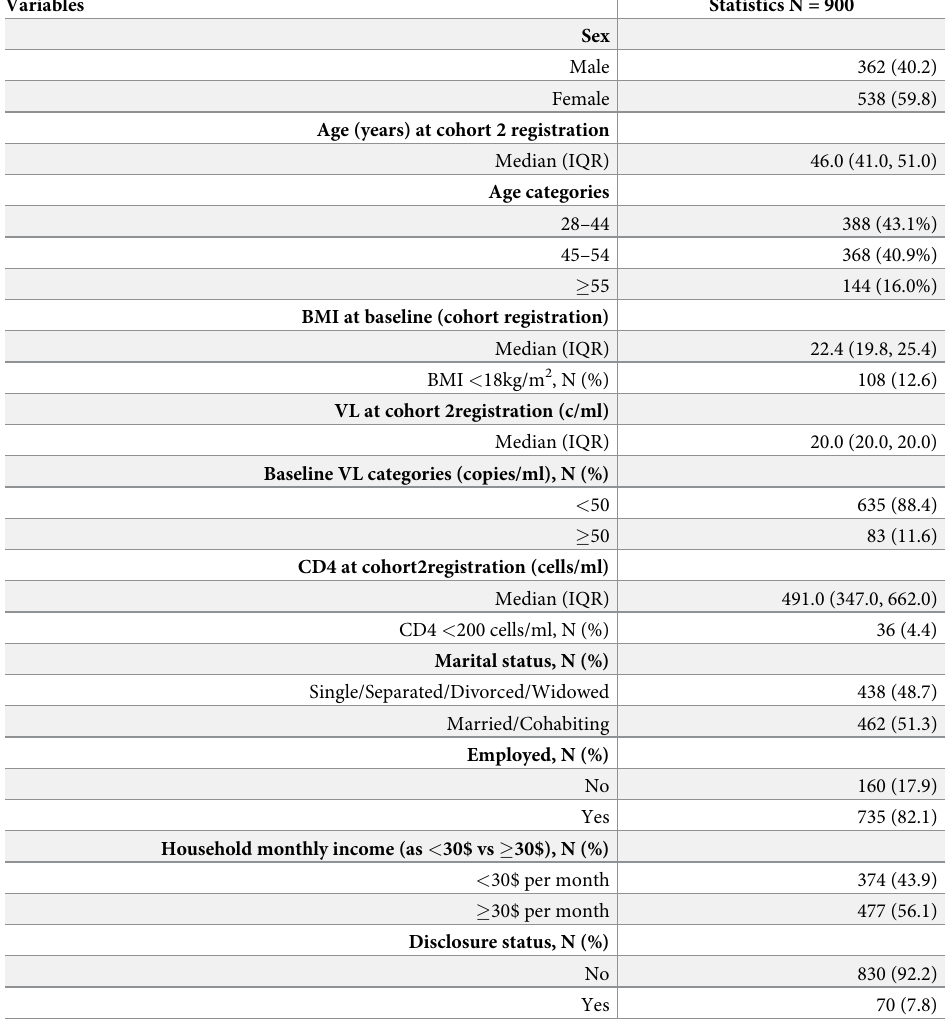
Table 1. Baseline characteristics (at 10 years on